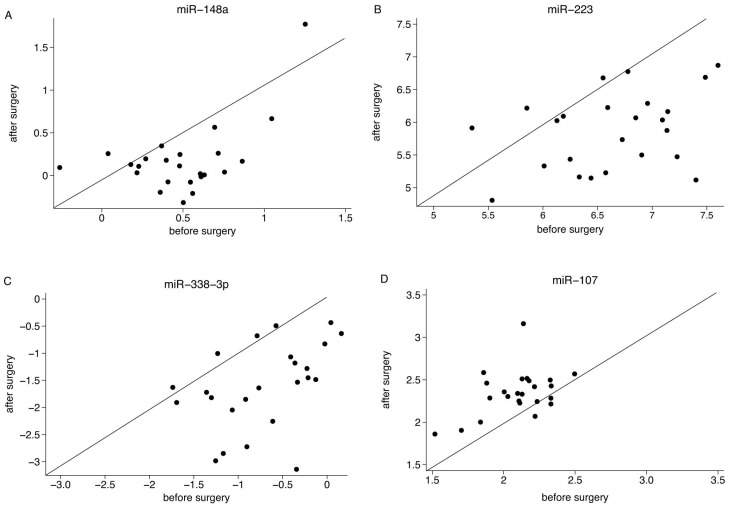
Scatter plots.Scatter plots showing the corresponding expression levels of (A) miR-148a, (B) miR-223, (C) miR-338-3p and (D) miR-107 for the paired pre- and post resection samples for each early-stage breast cancer patient (n = 24).